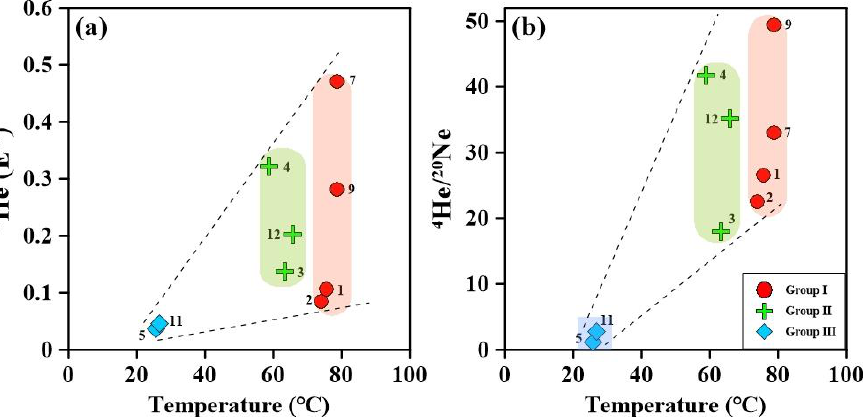
Figure 7. Plot of 3 He/ 4 He and 4 He/ 20 Ne ratios for air, crust and mantle mixing.